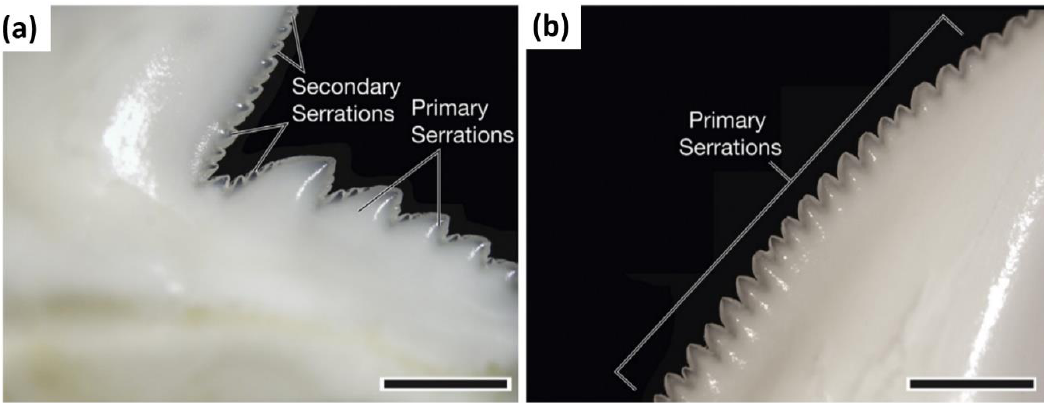
Figure 4. High-magnification light micrographs of the ( a ) primary and secondary serrations of the distal heel of the Galeocerdo cuvier shark tooth (scale bar of 2 mm), and ( b ) the primary serrations of the cutting edge of the Prionace glauca shark tooth (scale bar of 2 mm) (reproduced from Reference [70] with permission).